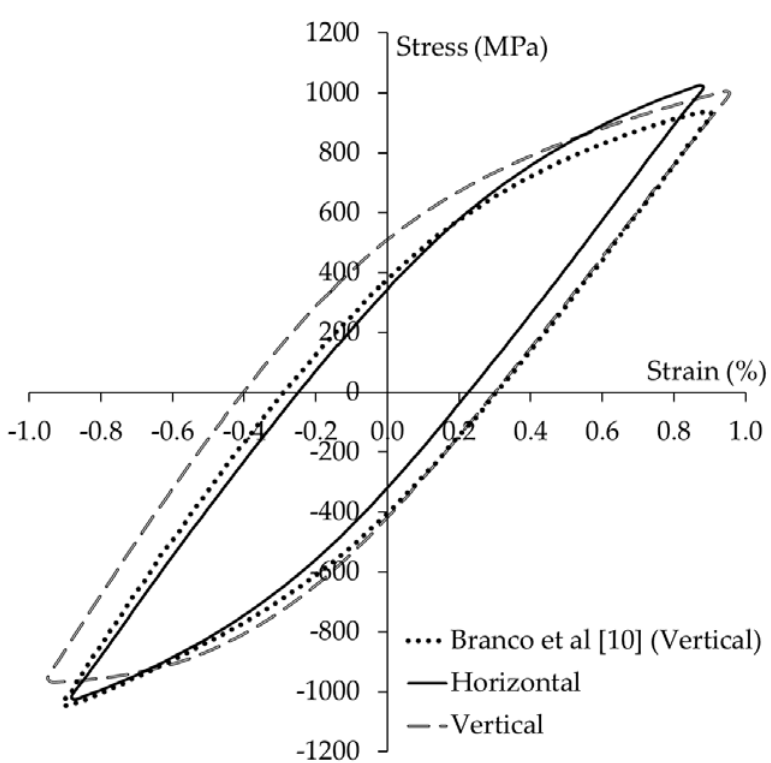
Figure 2. The hysteresis loops of the tested as-built EOS MS300 horizontal and vertical test coupons (at the 28th cycle) and the Branco et al. [10] published data for the as-built MS300 vertical coupon. The hysteresis loops of the tested coupons (vertical, horizontal) appear to have symmetry, both in terms of their shape and in absolute stress values (approximately 900 and 1000 MPa, respectively).